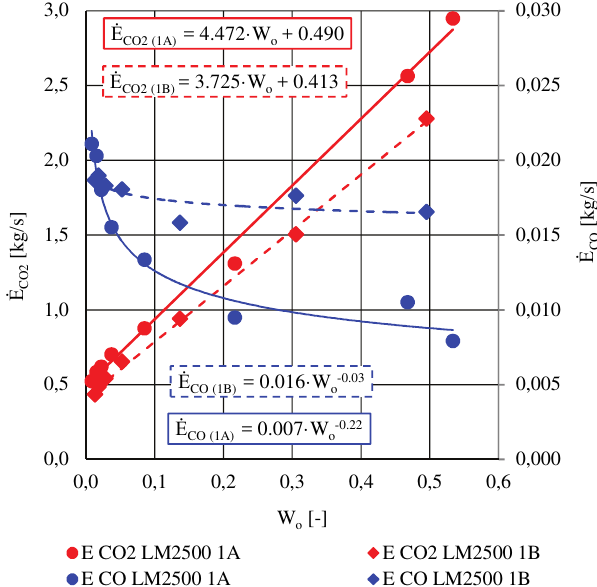
Fig. 9. The mass emission intensity of carbon dioxide ( E(cid:17) monoxide ( E(cid:17) ) in the LM 2500 1A and LM 2500 1B engines exhaust !" as a function of the engine load factor (W o )